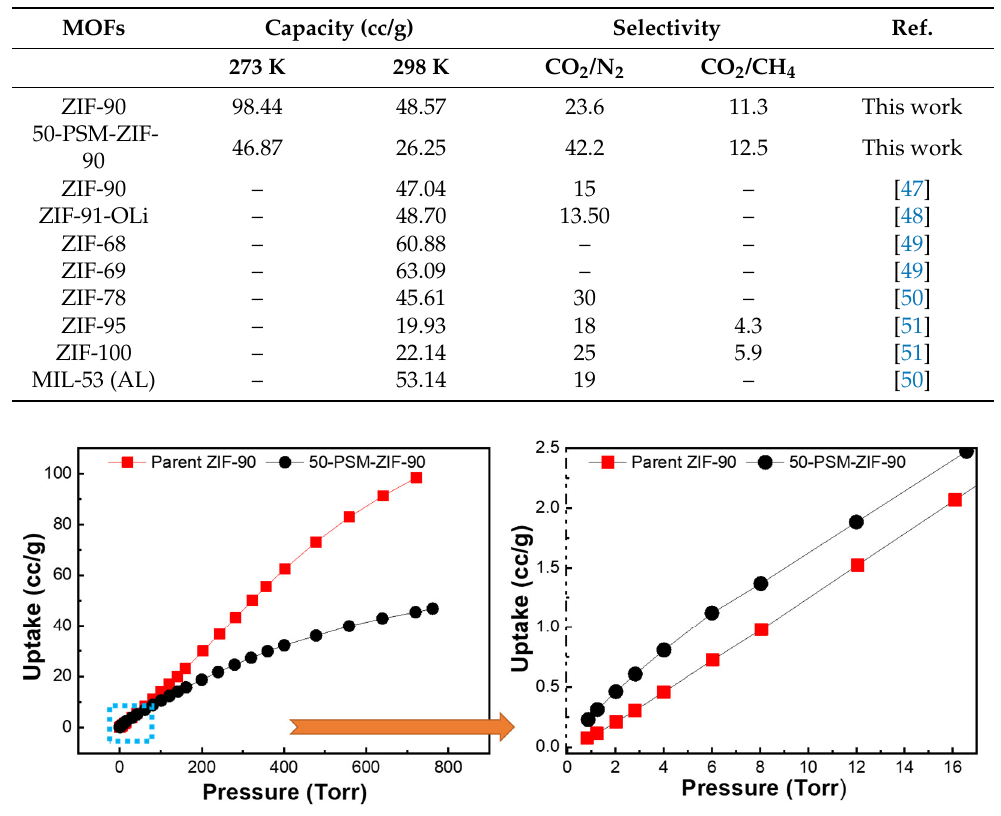
Figure 10. Gas isotherms for ( A ) ZIF-90 and ( B ) 50-PSM-ZIF-90 at 273, 298 and 313 K. Table 1. Carbon dioxide uptake and selectivity from the air and natural gas by different MOFs at 298 K adsorption temperature and at 1 bar pressure.